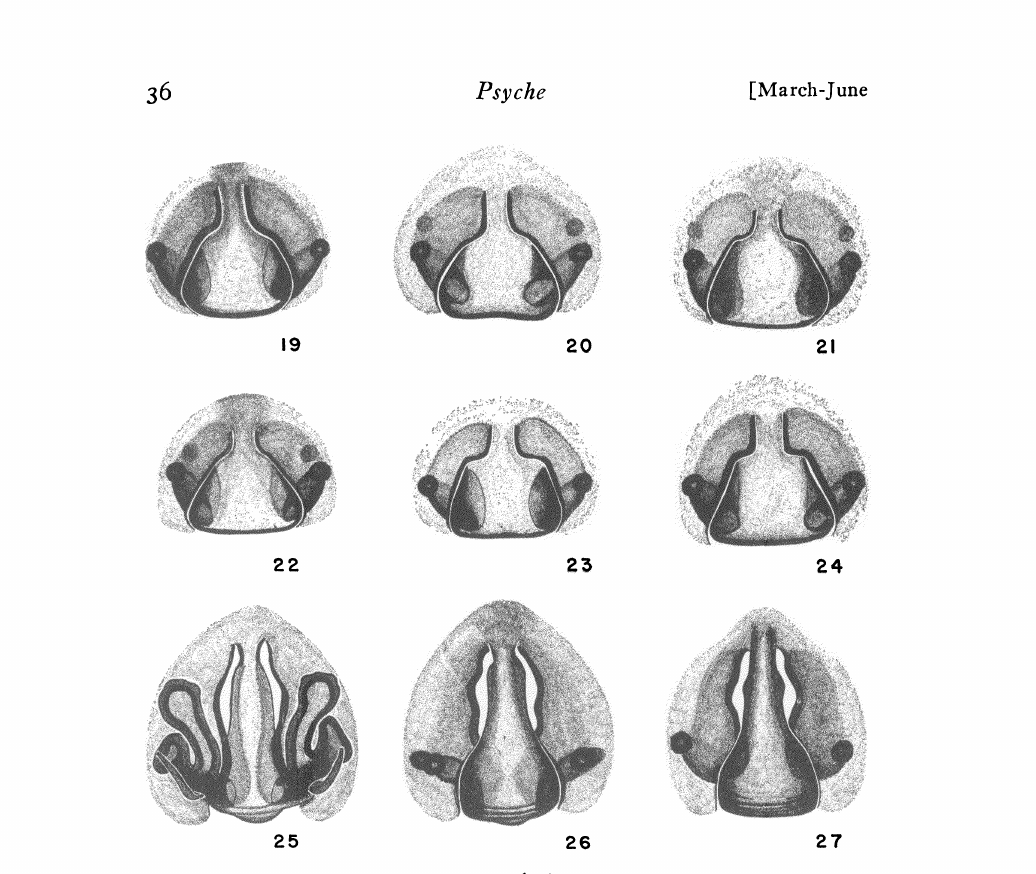
Figs. 19-24. Epigyna of Sosippus floridanus Simon showing variation. 19-20. Aripeka, Hernando Co., Florida, 13 June 1968. 21-22. One mile E of Horse Creek on St. Highway 72, Desoto Co., Florida, 12 June 1968. 23-24. Highlands Hammock St. Pk., Highlands Co., Florida, 19 June 1962. Figs. 25-27. Sosippus placidus sp. n., from 6 mi. S of Lake Placid, High- lands Co., Florida, 12 June 1968. 25. Internal genitalia, dorsal view. 26. Epigynum, showing variation. 27. Epigynum of female